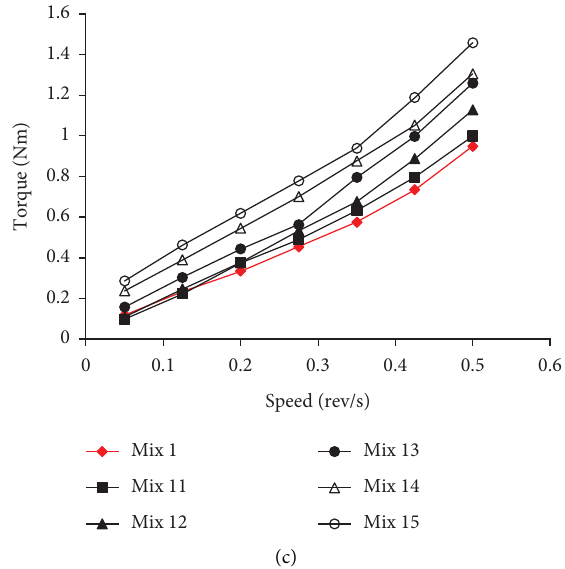
Figure 7: Torque vs. speed variation for SCCs (a) series no. 1, (b) series no. 2, (c) and series no. 3.